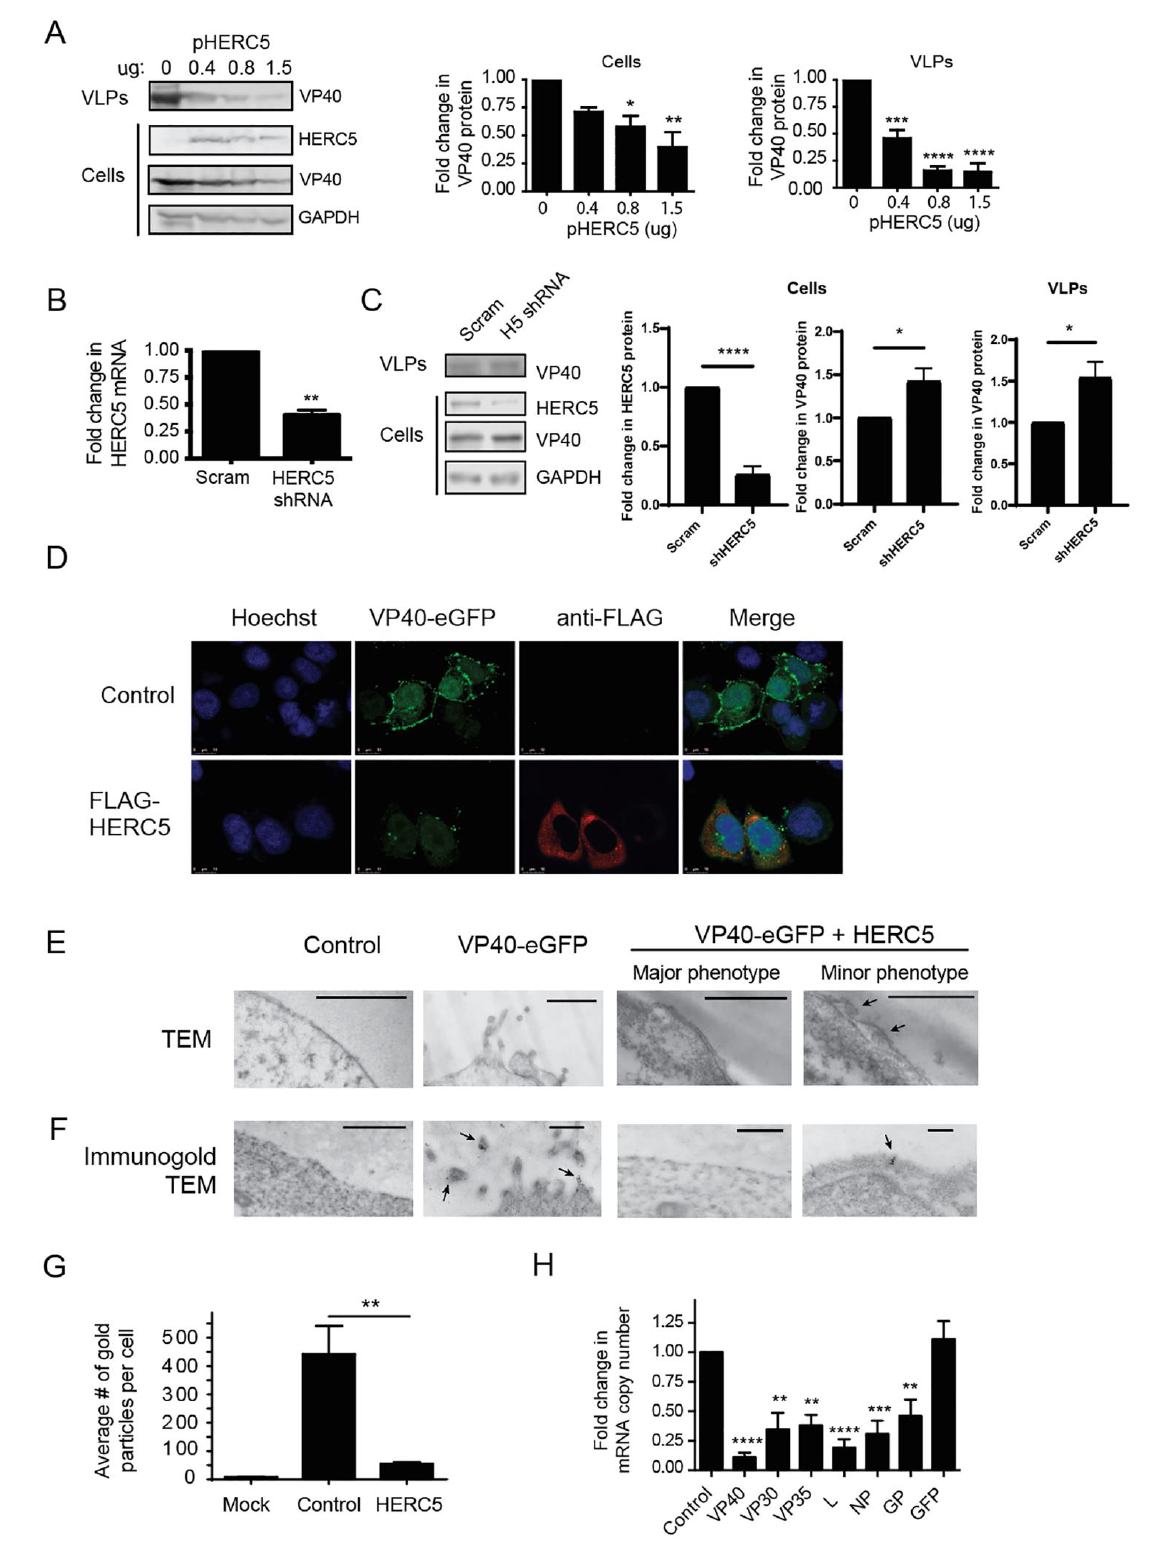
Figure 2. HERC5 inhibits EBOV VP40 particle production. ( A ) 293T cells were co-transfected with plasmids carrying FLAG-tagged VP40 (pFLAG-VP40) and increasing concentrations of FLAG-tagged HERC5 (pFLAG-HERC5). Empty